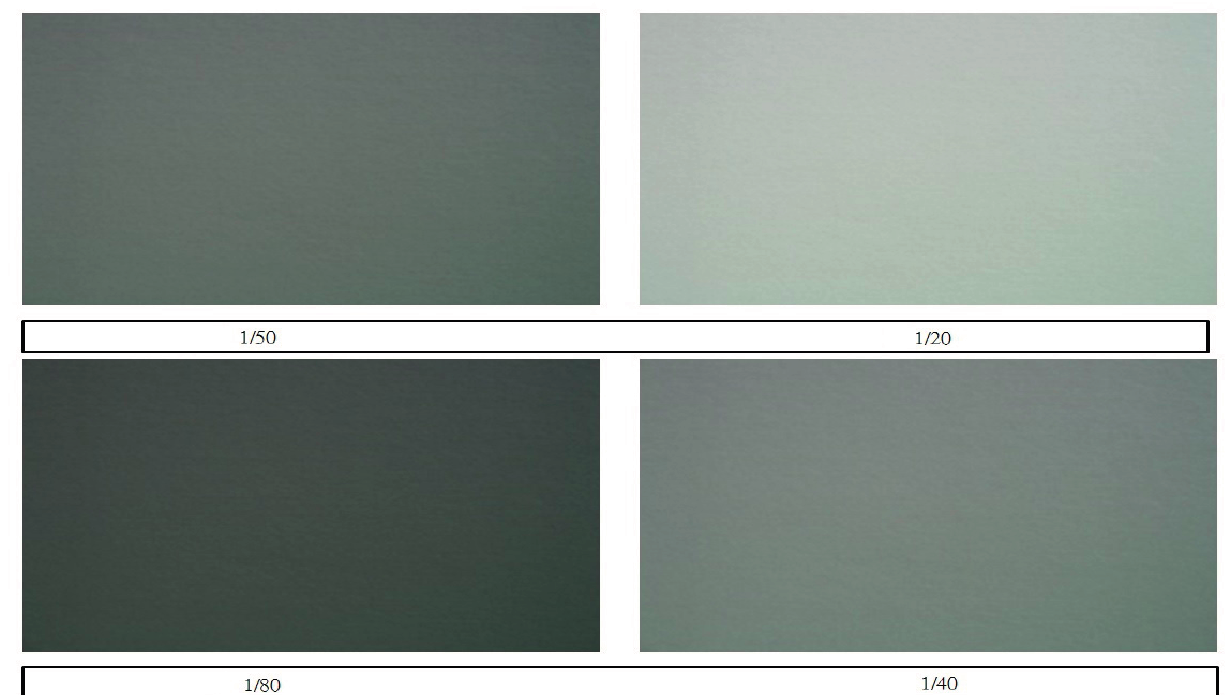
Figure 8. F10 aperture 2D/3D test